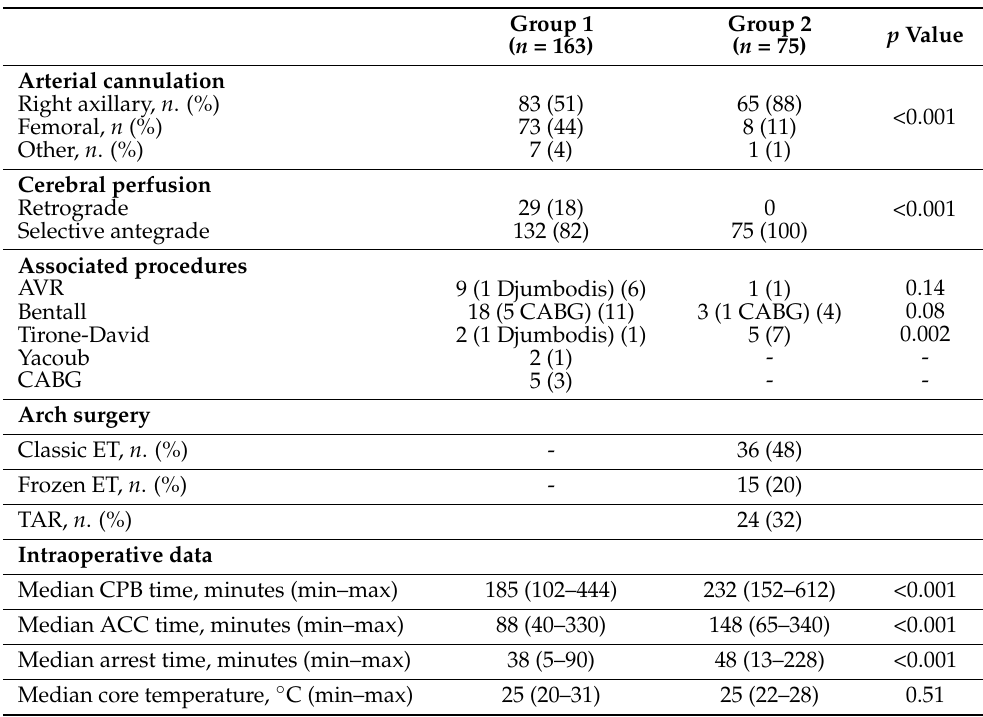
Table 2. Summary of surgical